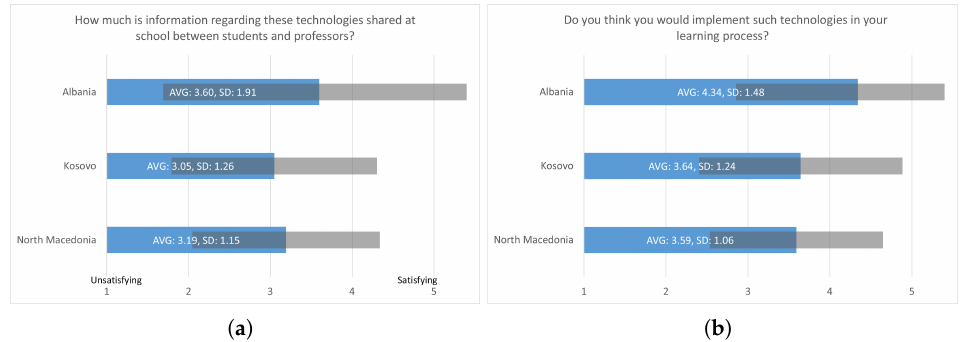
Figure 13. ( a ) Usage of digital technologies in free time. ( b ) Interest for training in digital